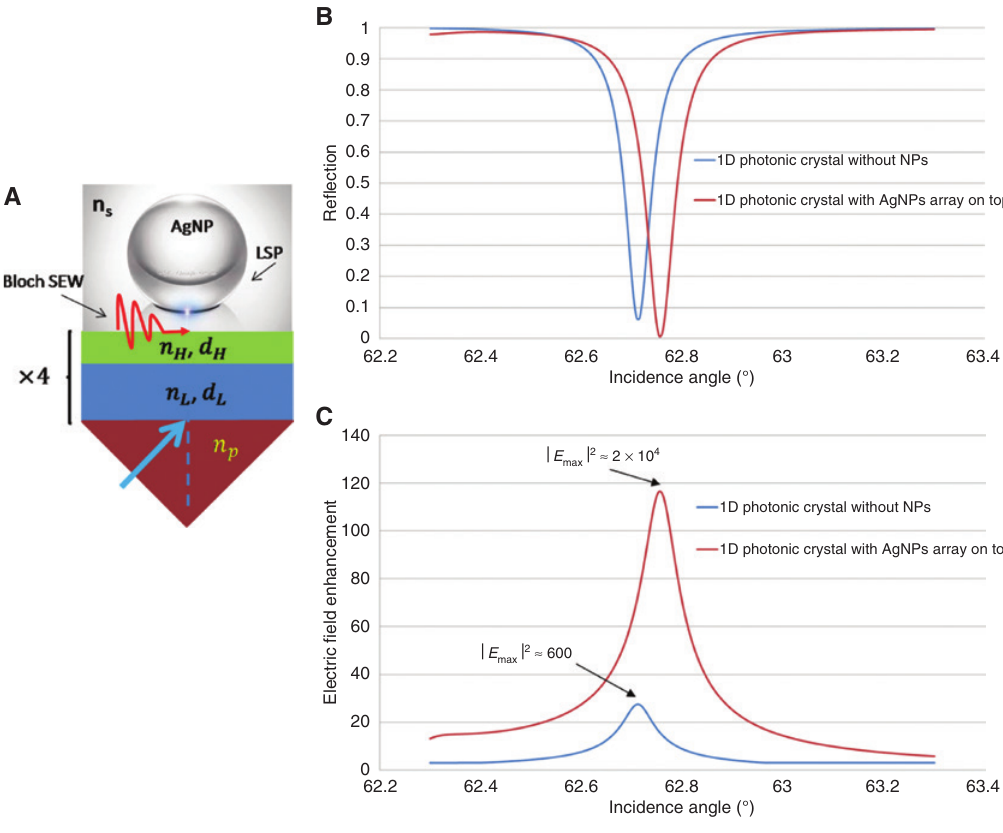
Figure 26: Bloch ESEW coupling configuration with LSPs (TE polarization). (A) Schematic. (B) Reflectivity of the structure. (C) Field amplitude enhancement factor. Parameters: n = 2.096 + i0.0002; d n H